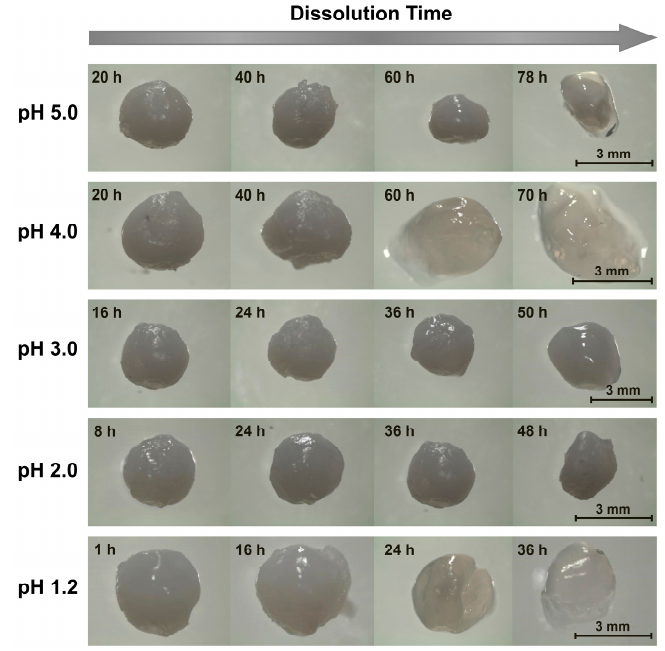
Figure 4. Representative images of chitosan/sodium salts of dodecyl sulfate (SDS) beads dissolving in pH 1.2–5.0 aqueous solutions ([NaCl] = 10 mM). pH 1.2–5.0 aqueous solutions ([NaCl] = 10